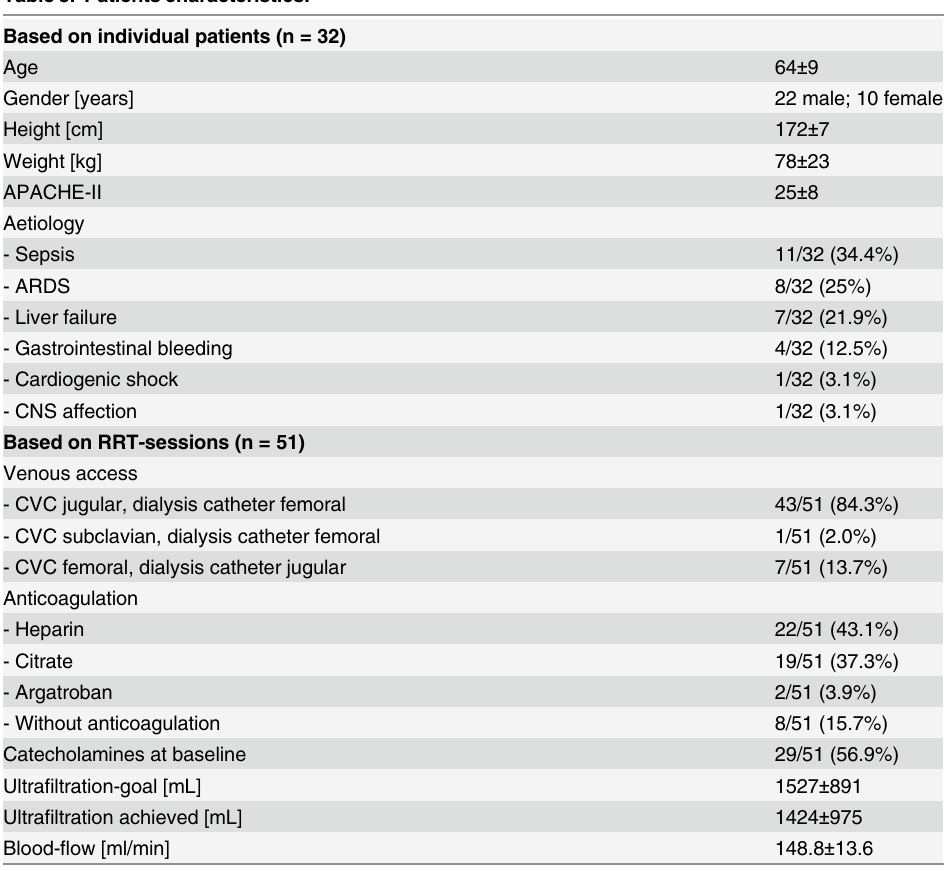
Table 3. Patients